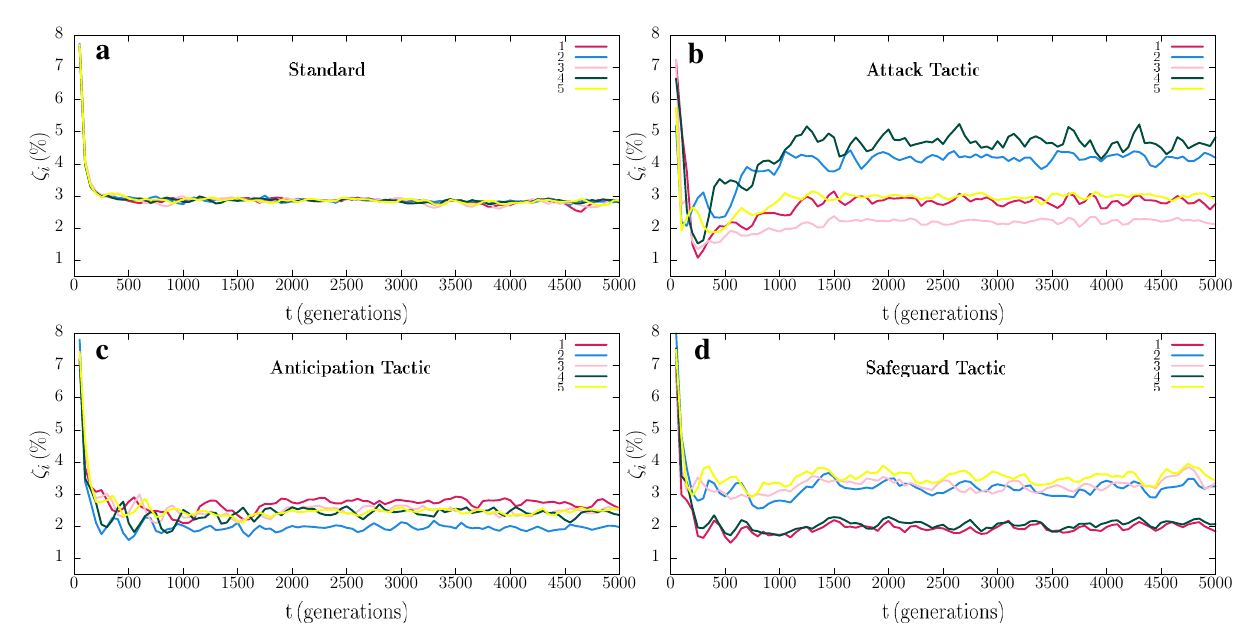
Figure 4. Dynamics of the species selection risks ζ i for the simulations presented in Fig. 2. The colours indicate the species following the scheme in Fig. 1. ( a ) Standard case, https:// youtu. be/ Ndvk6 Rg57m4. ( b ) Attack tactic, https:// youtu. be/ JGhkD AHSo74. ( c ) Anticipation tactic, https:// youtu. be/ ZZp9Q lOfv2Q. ( d ) Safeguard tactic, https:// youtu. be/ eFxWd